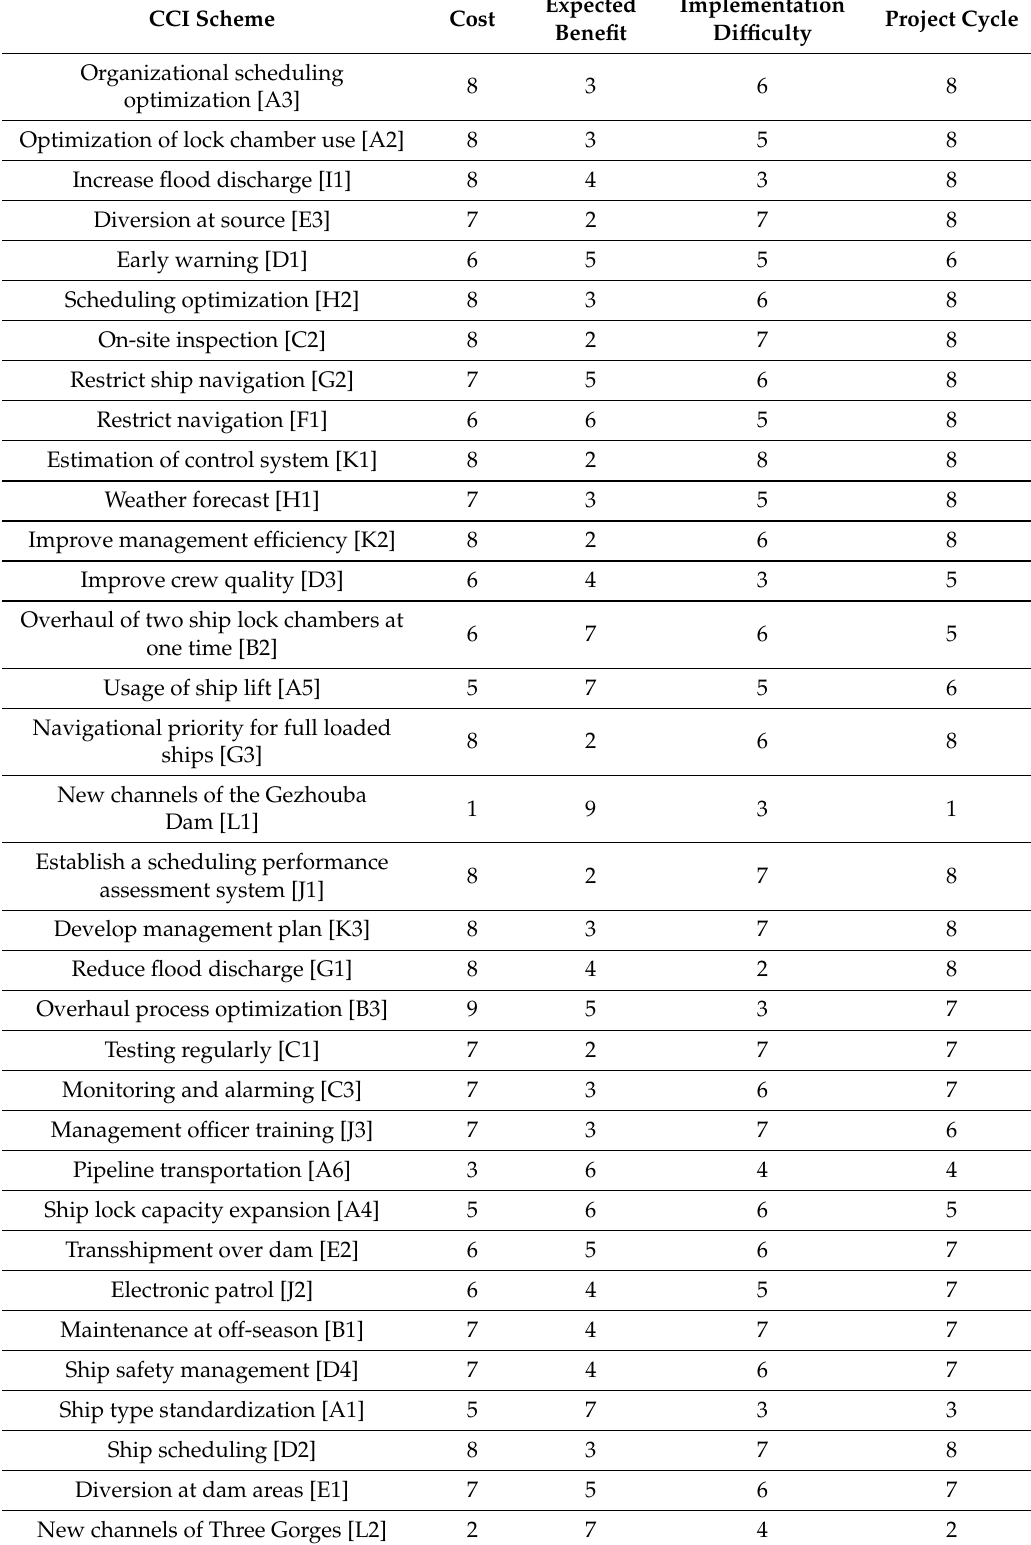
Table 10. Performance of CCI schemes of different